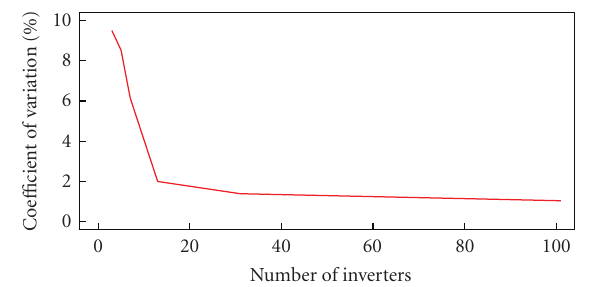
Figure 7: Dispersion of